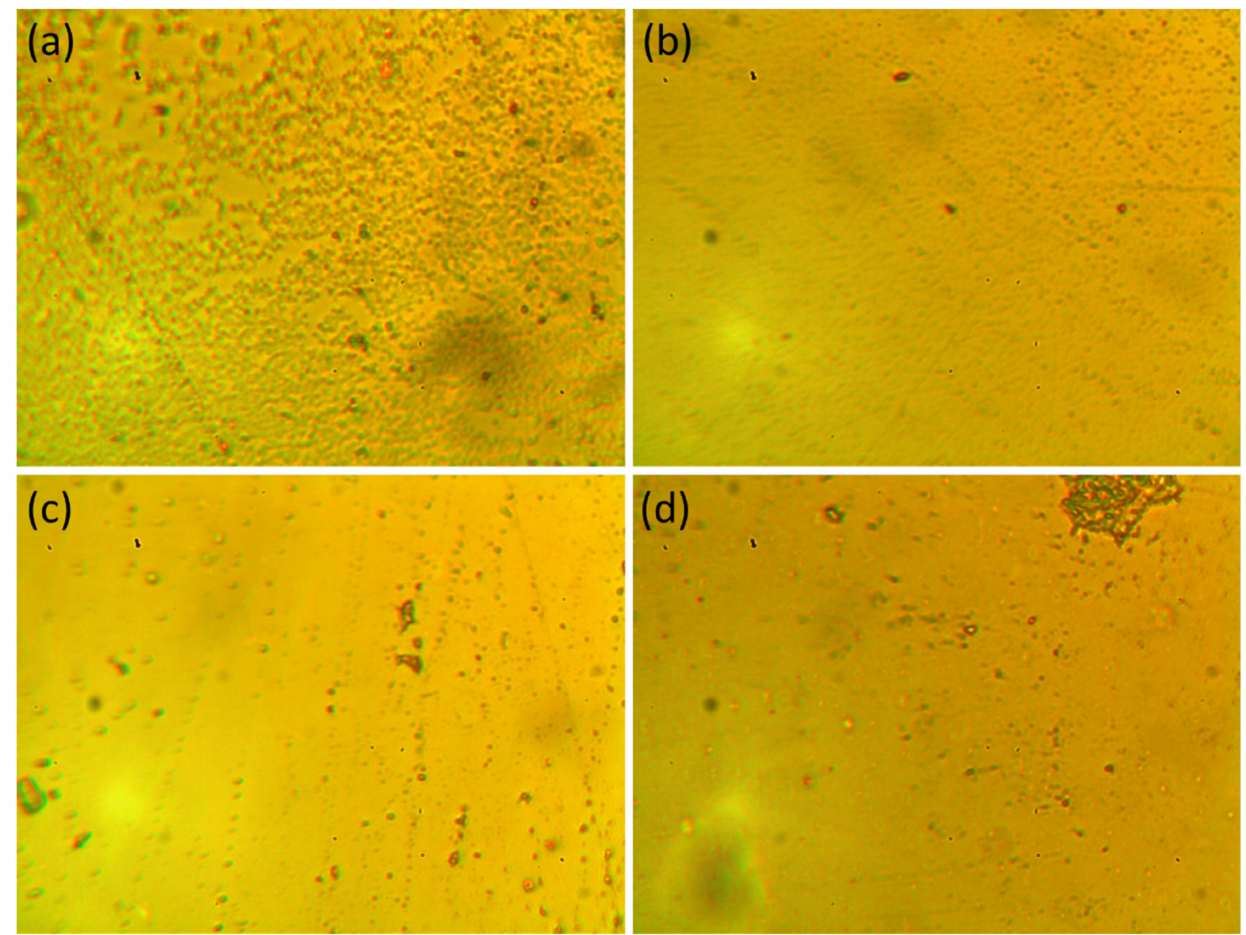
Figure 6. Microscope images recorded after 300 h of UV irradiation of PS blends containing ( a ) no additives, ( b ) ibuprofen–Mn complex, ( c ) ibuprofen–Co complex, and ( d ) ibuprofen–Ni